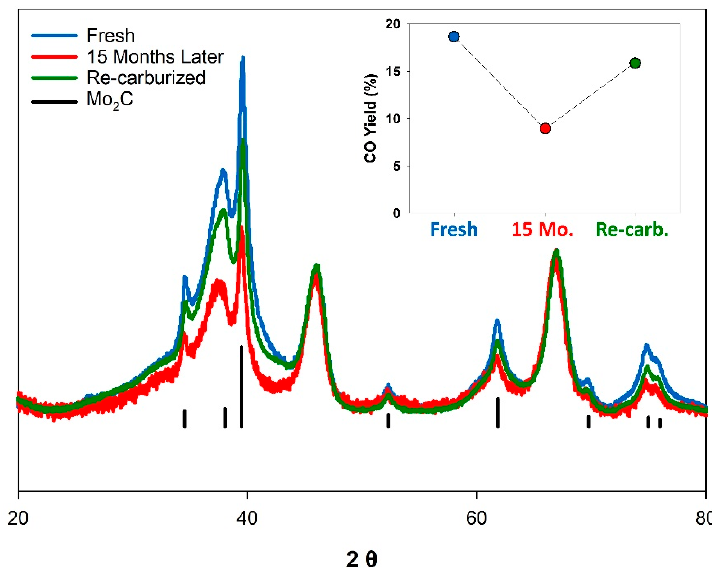
Figure 4. X-ray diffraction patterns normalized to the γ -Al 2 O 3 signal for “Fresh” ( blue ), “Aged” ( red ), and “Re-carburized” ( green ) K-Mo 2 C@ γ -Al 2 O 3 . Inset: CO Yield observed for the three catalysts under identical conditions (tested at 3:1- H 2 :CO 2 ratio, 2.0 MPa, at 300 °C and at a GHSV of 3600 L kg − 1 h − 1 ).